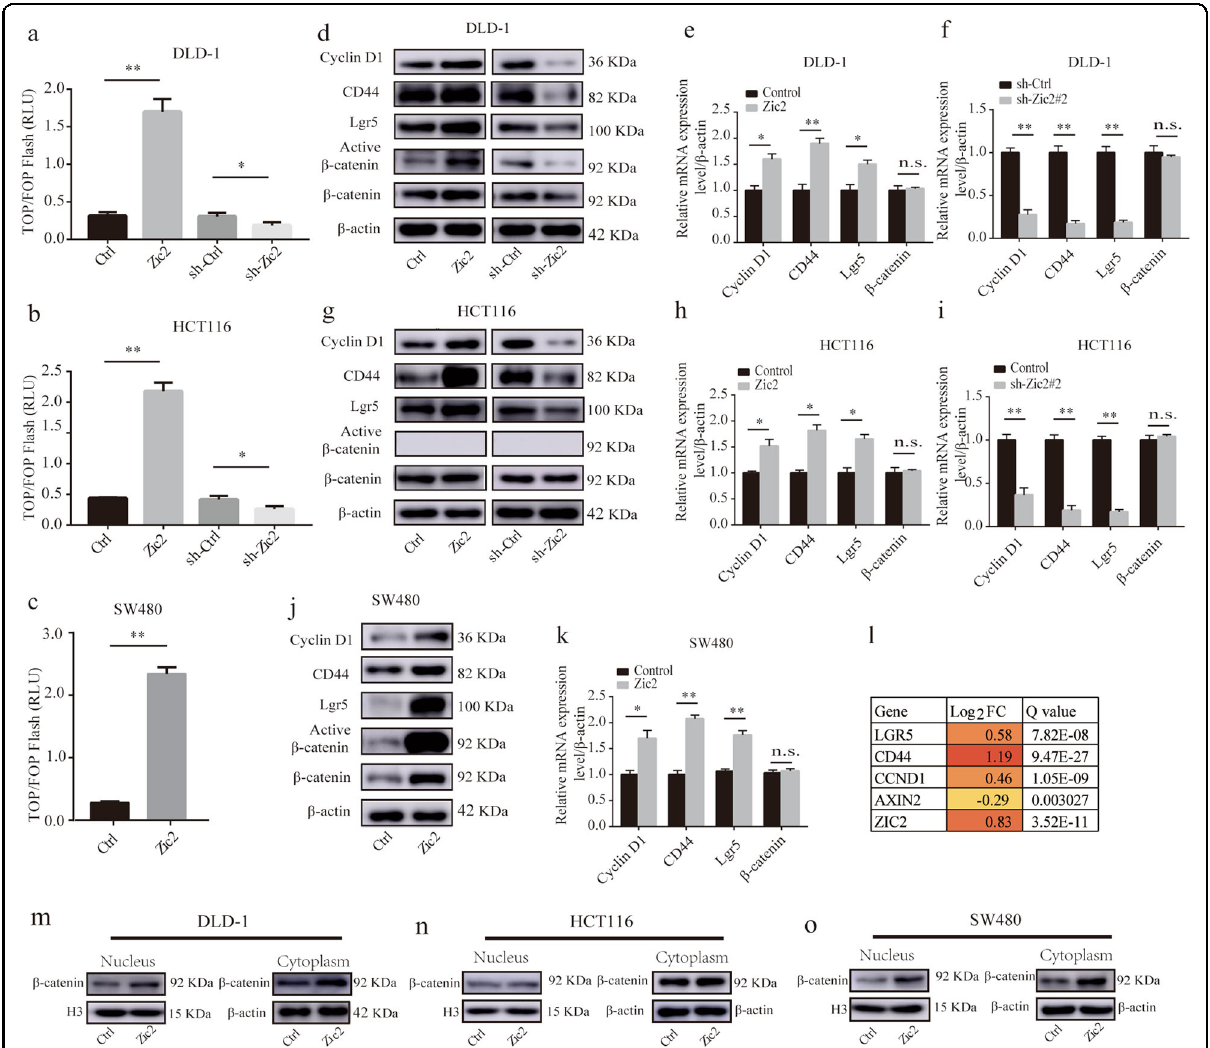
Fig. 4 Zic2 enhances Wnt signaling activity in colon cancer cells. a – c The luciferase reporter activities in Zic2- silencing Zic2 and Zic2- overexpressing cell lines transfected with a TOP/FOP-Flash reporter plasmid. d , e , f , g , h , j , k The expression levels of Cyclin D1, CD44, Lgr5, active β -catenin (Ser 45), and β -catenin were detected in silenced Zic2- silencing and Zic2-overexpressing cell lines by west blotting ( d , g , j ) and qRT-PCR ( e , f , h , i , k , l ). l mRNA expression changes of Cyclin D1, CD44, Lgr5, axin2 in DLD-1-Zic2 cells and control DLD-1 cells are analyzed by RNA-seq and presented in the color-coded format. The fold changes were log2 normalized. m – o β -catenin co-immunoprecipitation with Zic2 in cell lines by western blot. All data are the mean ± SD of three independent experiments. * P < 0.05, ** P <